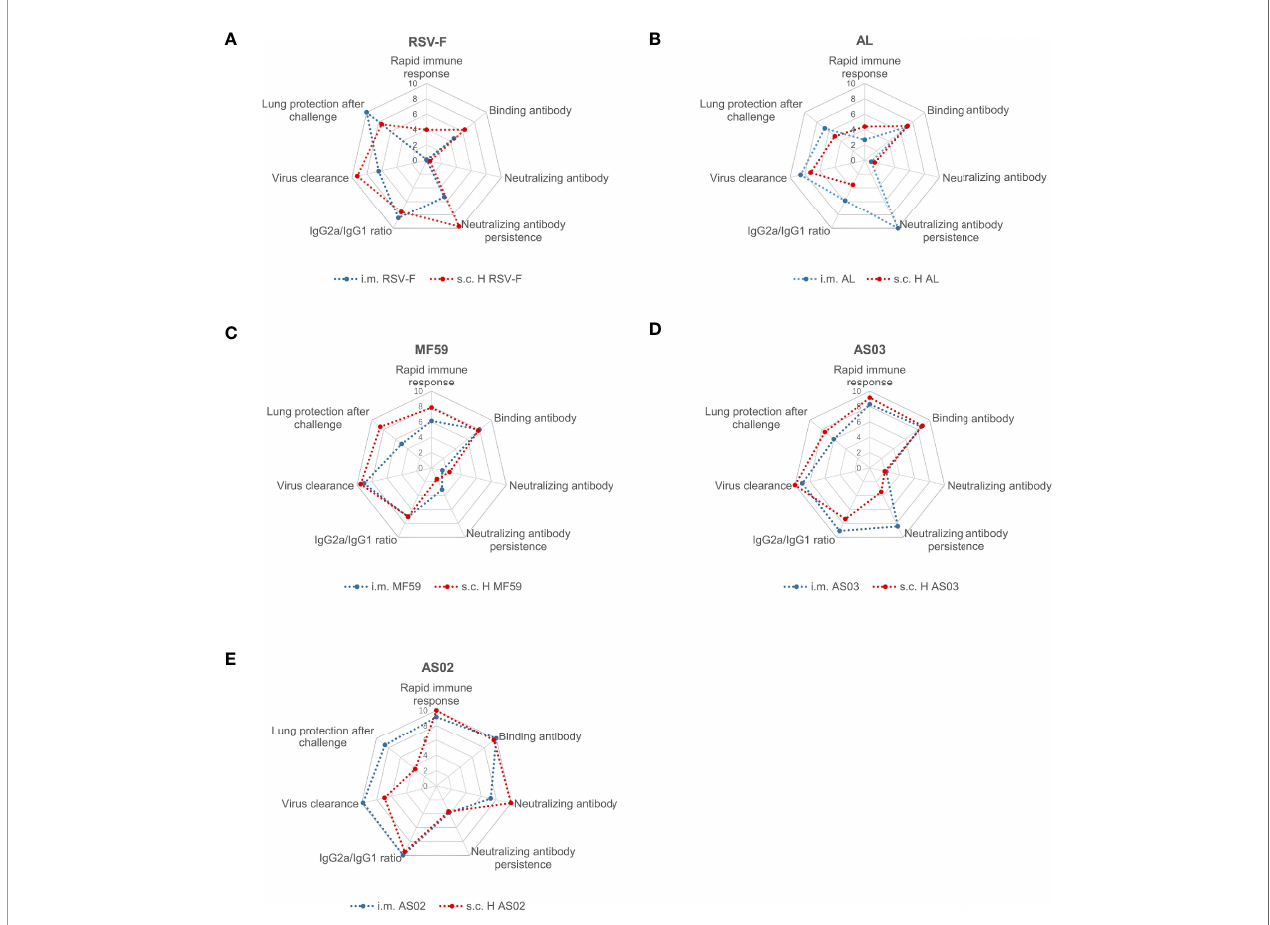
FIGURE 9 | Radar chart of RSV-F vaccines with or without adjuvants via intramuscular and subcutaneous routes. RSV-F alone (A) , Alhydrogel-adjuvanted vaccine (B) , MF59-adjuvanted vaccine (C) , AS03-adjuvanted vaccine (D) , and AS02-adjuvanted vaccine (E) . The radar charts were de fi ned as seven dimensions, namely “ Rapid immune response ” (D1), “ Binding antibody ” (D2), “ Neutralizing antibody ” (D3), “ Neutralizing antibody persistence ” (D4), “ IgG2a/IgG1 ratio ” (D5), “ Virus clearance ” (D6) and “ Lung protection after challenge ” (D7) dimension. The evaluation indexes Di was normalized with the method in the supplementary material, and integrated into the radar chart by the software of Excel. Within each chart, different axes represented different evaluation indexes that shared the same metric scale (0 – 10), and the value increased with distance from the